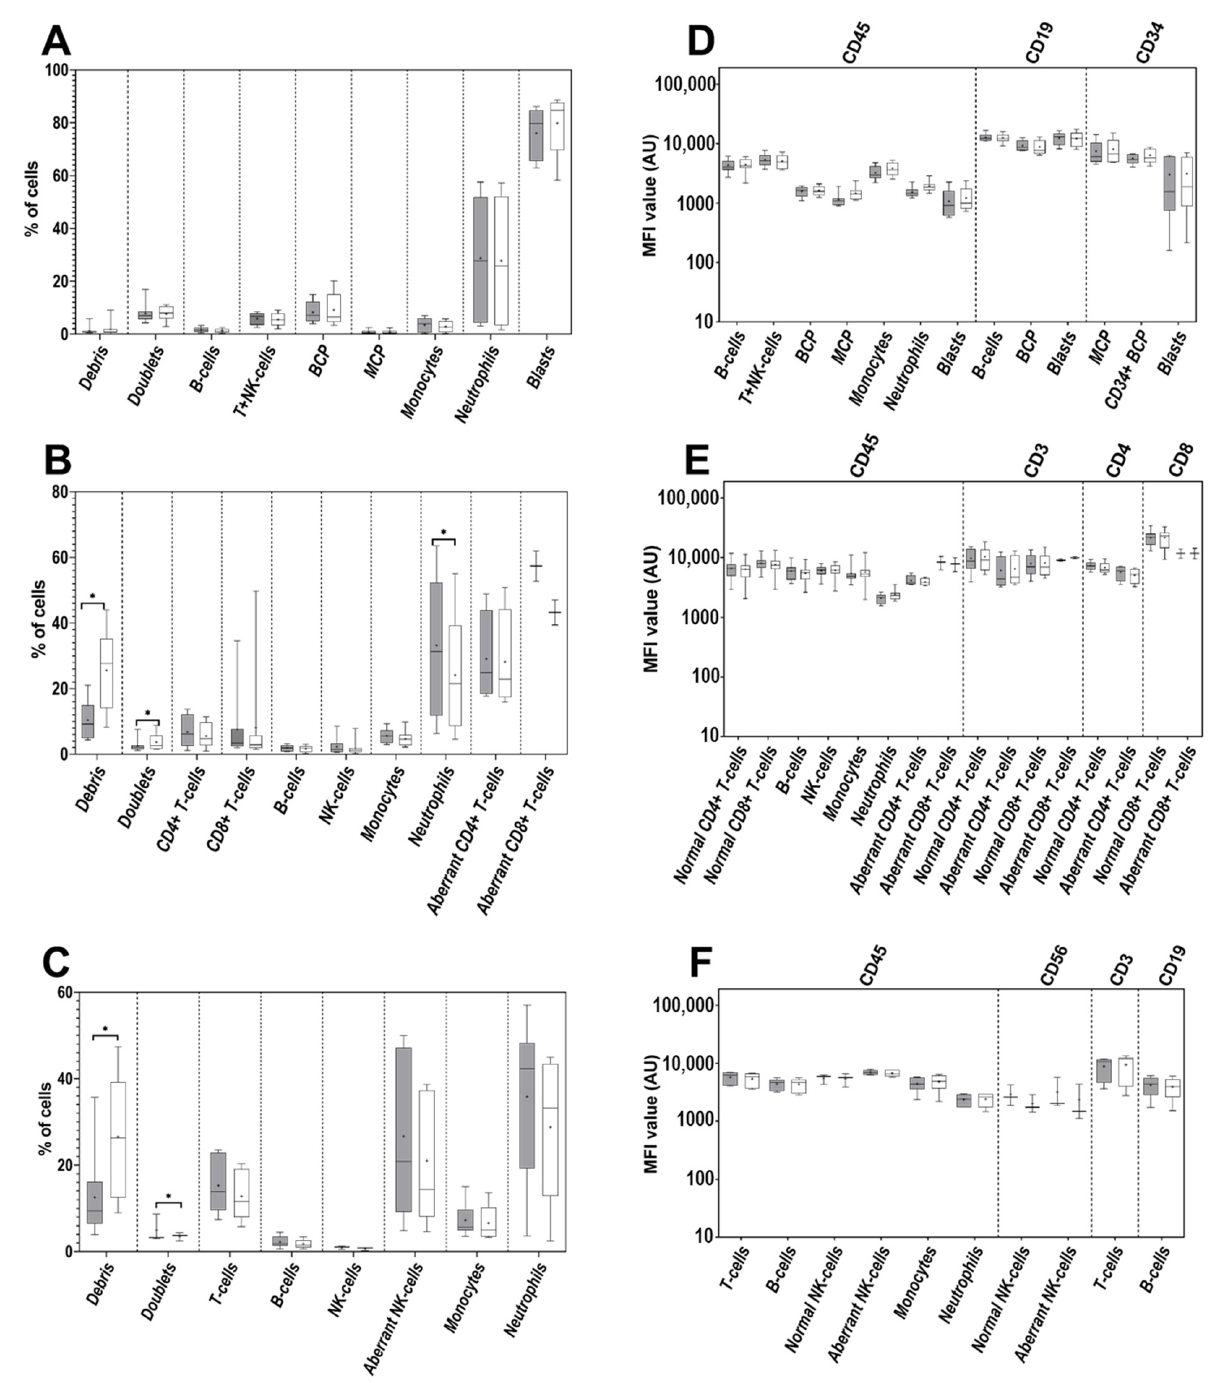
Figure 4. Comparison of the cell surface-only vs. cell surface plus intracellular staining protocols; panels ( A – C ): relative distribution of the normal and aberrant cell populations identifiable with the BCP-ALL ( n = 5), T-CLPD ( n = 8) and NK-CLPD ( n = 5) antibody combinations, respectively; panels ( D – F ): backbone markers MFI on normal and aberrant cell populations stained with BCP-ALL, T-CLPD and NK-CLPD panels. Dark boxes represent cell surface only- (SM) and light boxes cell surface plus intracellular (SM+CY) staining protocol. The median and mean MFI values are indicated inside the boxes with a line and “+” sign, respectively. The boxes spread between first and third quartile of the obtained MFI values and whiskers span between minimal and maximal values. Asterisks indicate significant differences in MFI between particular time points ( p < 0.05). BCP—B-cell precursor cells; MCP—myeloid precursor cells; PC—plasma cells.